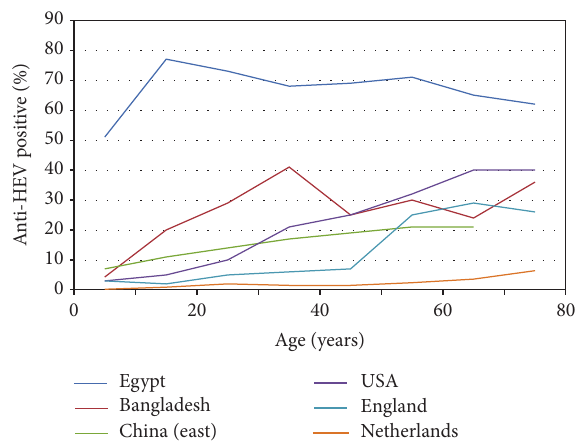
Figure1:Examplesofthepatternsofacquisitionofanti-HHEVwith age among the population from regions endemic for HHEV1 (Egypt, Bangladesh, and East China) [5–7] or HHEV3 (USA, England, and The Netherlands)